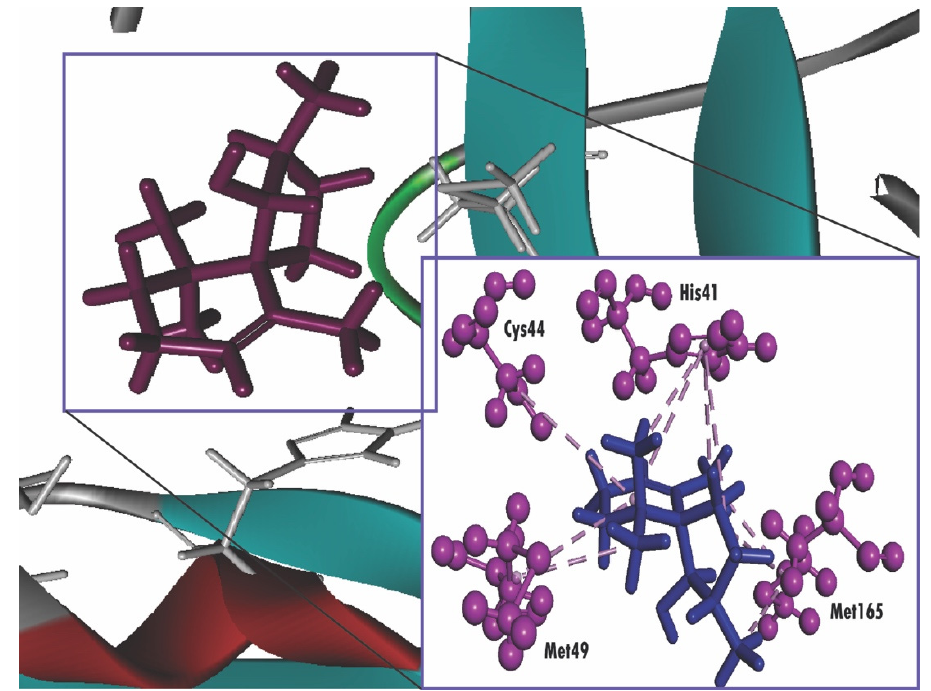
Figure 4. Molecular docking interaction between the SARS-CoV-2 M pro and spiro[4,5]dec-6-en-1-ol, 2,6,10,10-tetramethyl. Ligand in the active site is shown in purple color, and ligand interacting with the residues are shown in blue color, pink color illustrated the residues with hydrophobic (pi-pi / pi-alkyl) stacking.